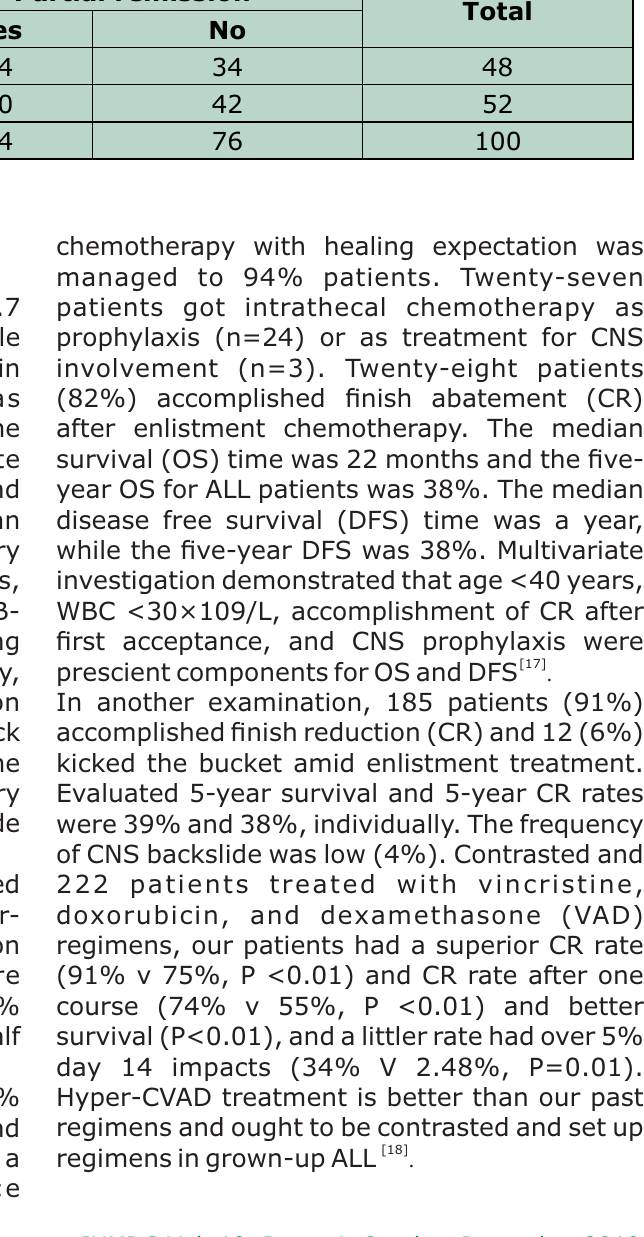
Table-II: D  istribution of patients by partial remission (n=100)